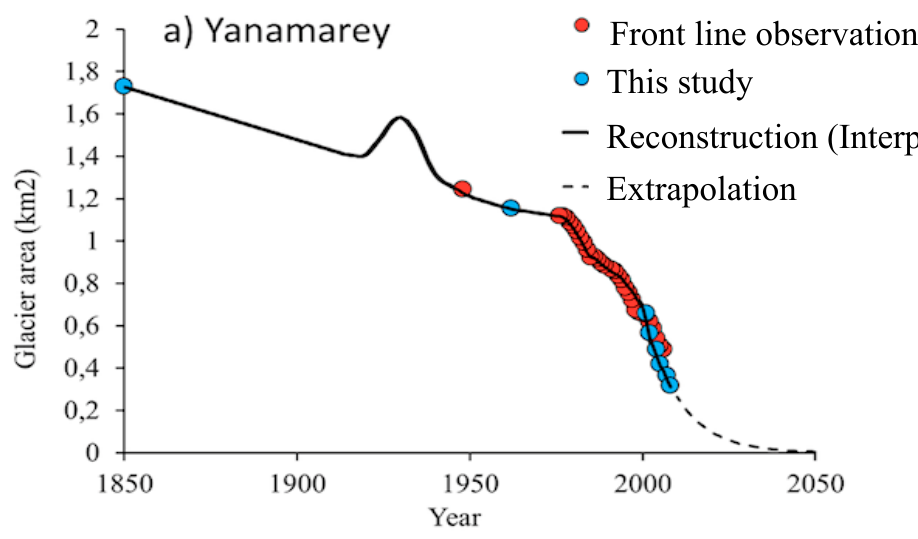
Figure 11. The change in surface area of YAN. Data of 1850 AD (blue dot in 1850 AD) are the results from the CA model. The observation (glacier length) data (red dots; 1948 and late 1970s to early 2000s) [73] agree well with the glacier area size measured from aerial photos (12 June 1962) and the series of ASTER imagery for this study (blue dots during 2001–2008 AD) [65]. The thick black line is the interpolation of the change in glacier extent. The information of the glacier re-advance (late 1920s to early 1930s) is included in the interpolation [65].